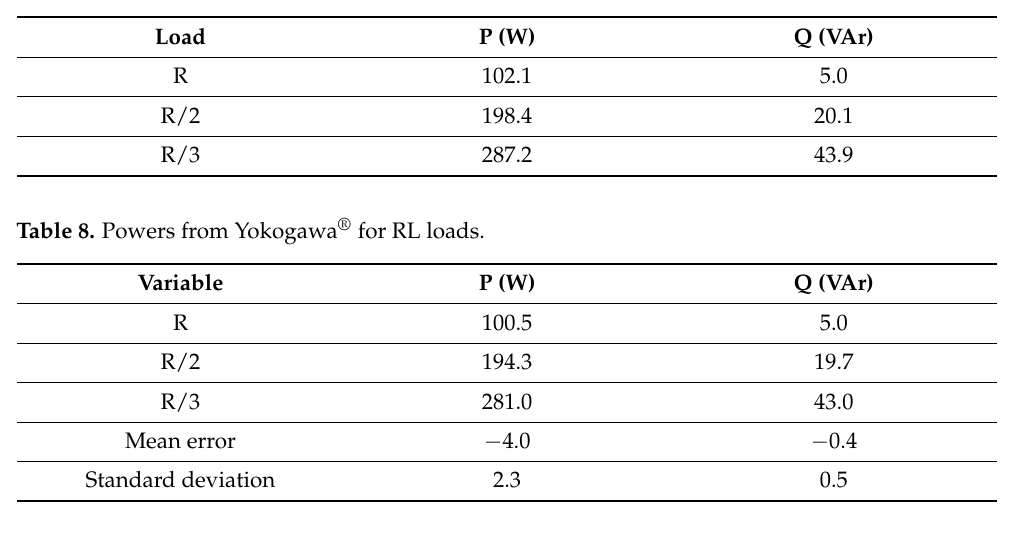
Table 7. Expected power values—RL loads.